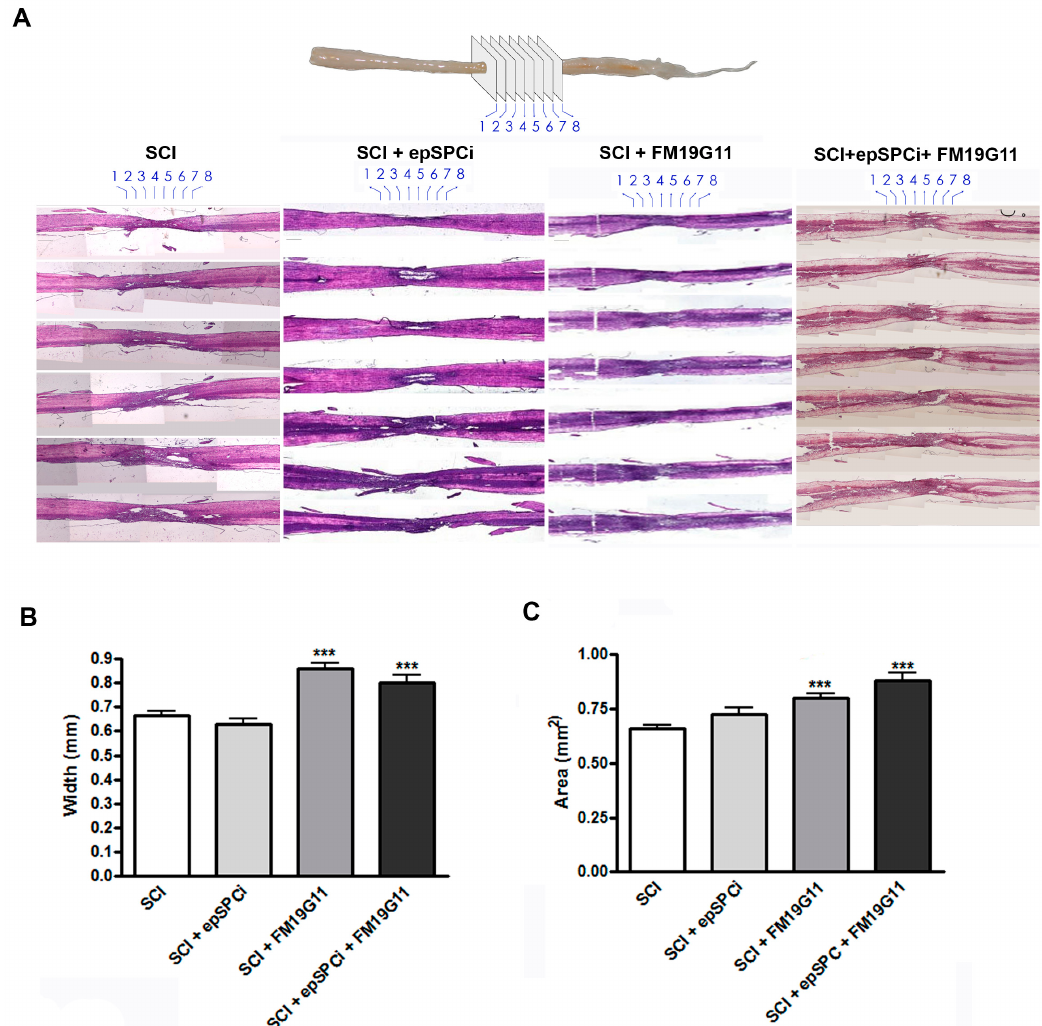
Figure 2. FM19G11 preserves spinal cord tissue. ( A ) Top panel: spinal cord model showing the eight selected points for the quantification of the width and the lesion area at the spinal cord injury epicenter; bottom panels: representative histological sections of hematoxylin/eosin staining for each experimental condition; Scale bar = 500 µM; ( B ) quantification of the whole width epicenter area, including all eight selected points; ( C ) quantification of the lesion area considering the elliptic shape of the spinal cord, the higher and smaller radius at each section. Quantitative data are expressed as the mean ± S.E.M; *** p < 0.001 in comparison with SCI (control).